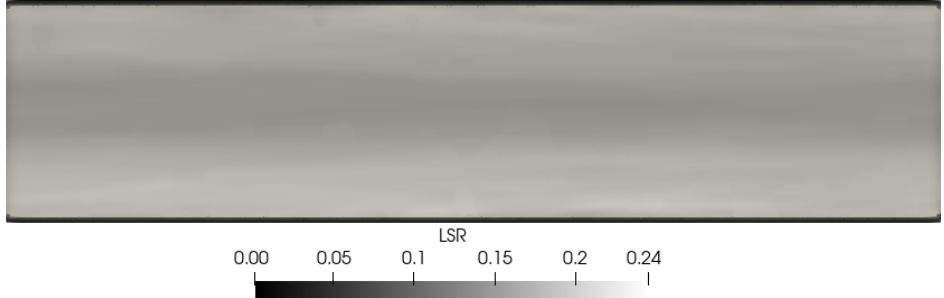
Figure 4. Display of the grid with layers at the inlet of the RIB-2